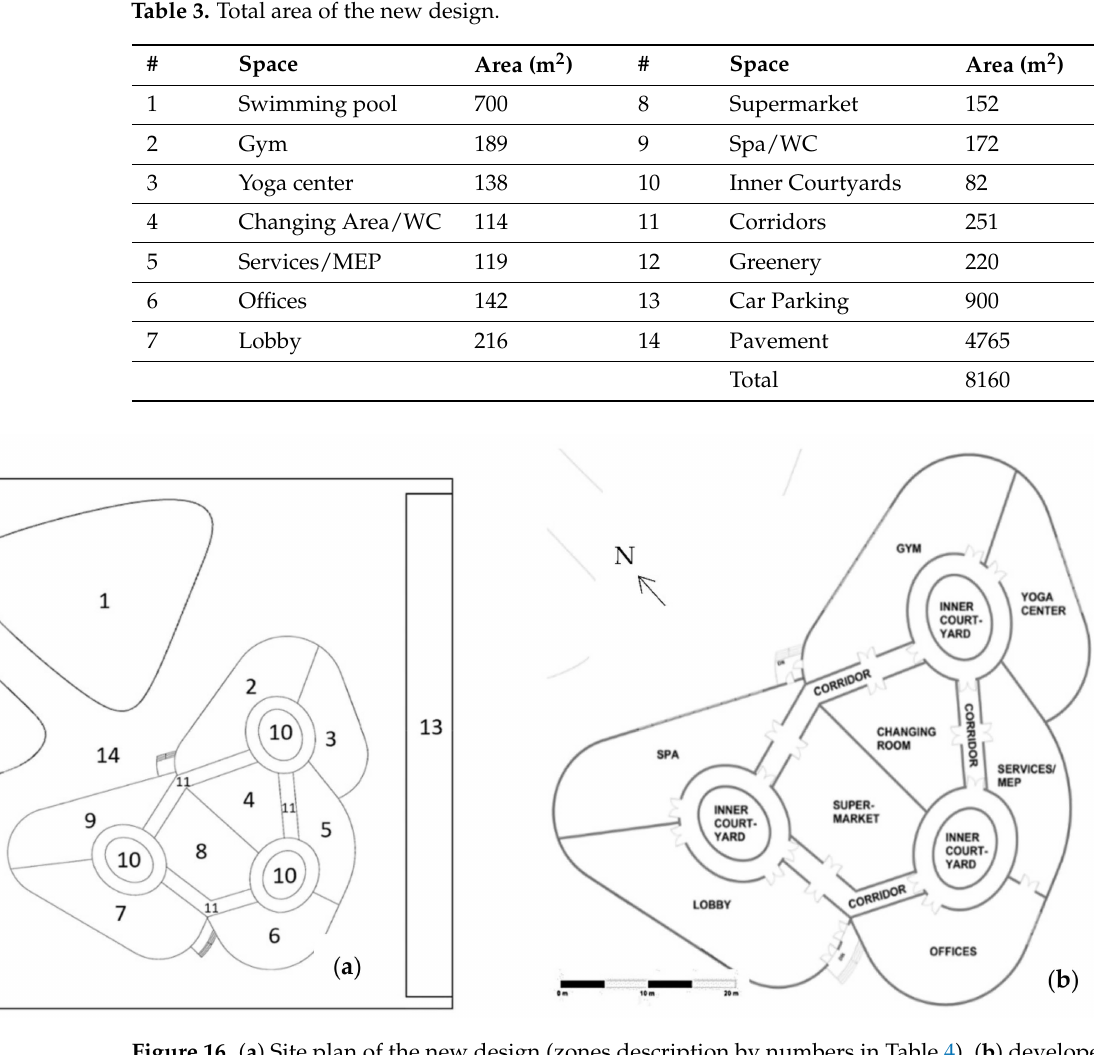
Figure 16. ( a ) Site plan of the new design (zones description by numbers in Table 4), ( b ) developed floor plan of the new design (plan